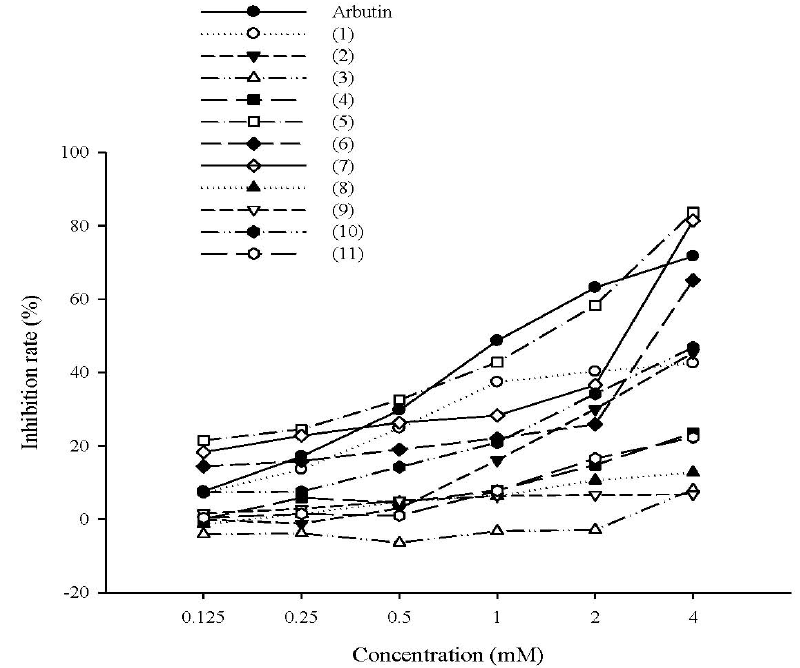
Figure 2. The rate (%) of inhibition of mushroom tyrosinase by tyrosol and its analogues (Tyrosol ( 1 ); 2-(3-hydroxyphenyl)ethanol ( 2 ); 2-(2-hydroxyphenyl)ethanol ( 3 ); 2 - (4-hydroxy-3-methoxyphenyl)ethanol ( 4 ); 4-hydroxyphenylacetic acid ( 5 ); 3-hydroxyphenylacetic acid ( 6 ); 2-hydroxyphenylacetic acid ( 7 ); 2-methoxyphenethyl ethanol ( 8 ); 3-methoxyphenyl ethanol ( 9 ); 4-methylphenyl ethanol ( 10 ); and salidroside ( 11 ). Data are reported as means ± S.D ( n =